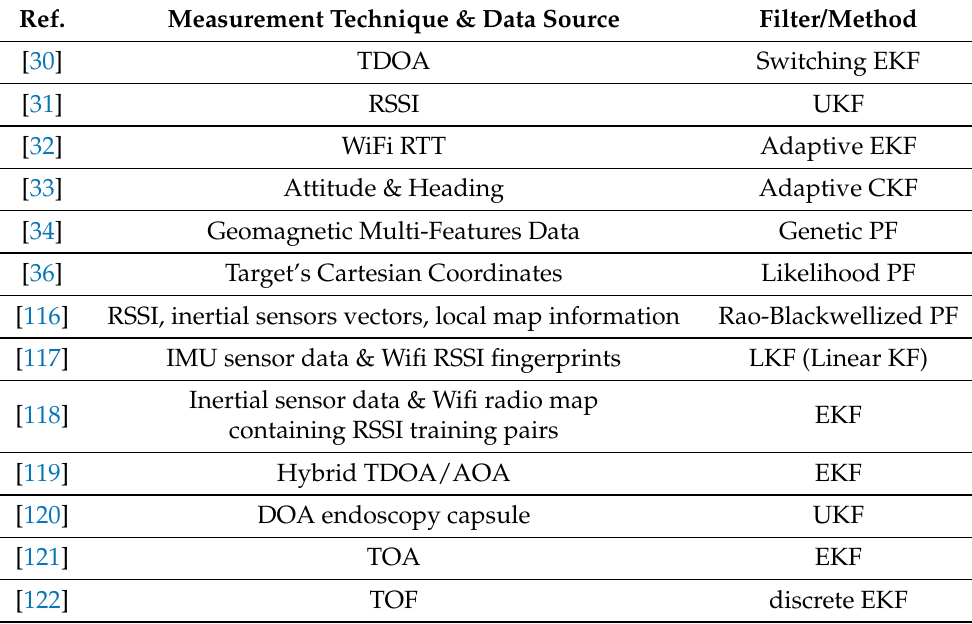
Table 3. Comparison of existing non-linear stochastic filters methods and their objectives.